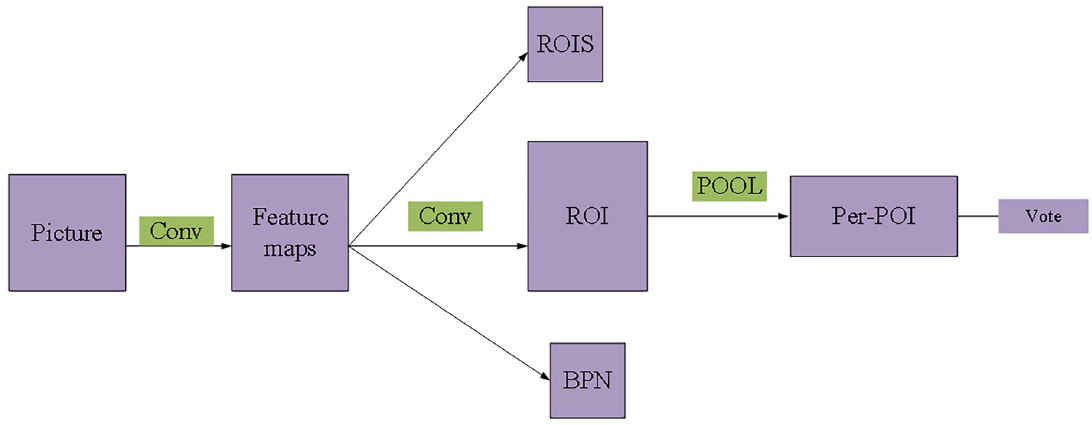
Fig 2. Procedure of